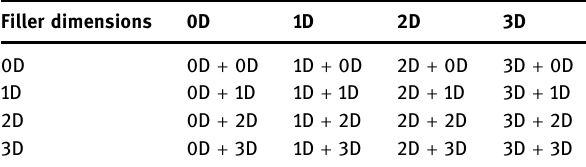
Table 2: Possible hybrid fi ller combination sets Filler